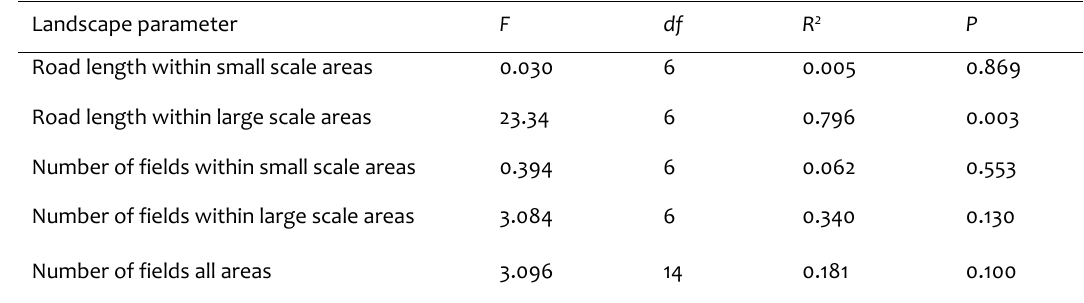
Linear regressions of the number of feral and volunteer oilseed rape plants related to landscape parameters. Significant ( P < 0.05) parameters are in